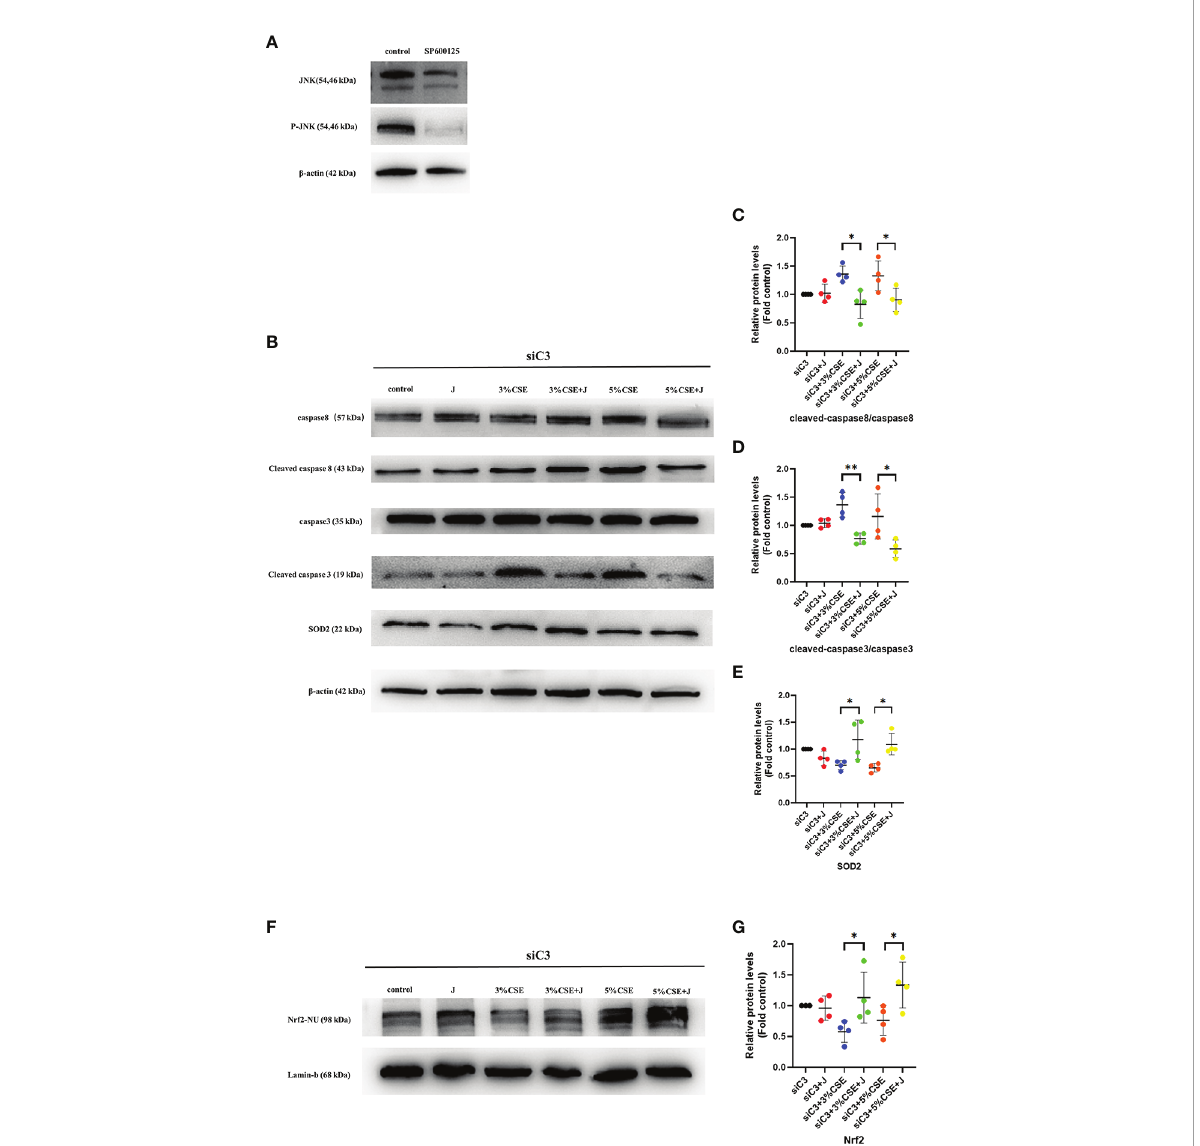
FIGURE 7 Pharmacological inhibition of the JNK pathway with SP600125 rescued CSE-induced oxidative stress and apoptosis in C3KD cells. C3KD cells were treated with SP600125 (10 m M) for 1 h, then stimulated with 3% or 5% CSE for another 24 h. (A) SP600125 signi fi cantly inhibited the level of JNK pathway activation by western blot. (B-G) Pharmacological inhibition with SP600125 rescued increased protein levels of cleaved caspase 8 and cleaved caspase 3 induced by CSE, while mitigating decreased protein levels of Nrf2 inside the nucleus and SOD2 induced by CSE. *P < 0.05, **P < 0.01. N = 4 independent